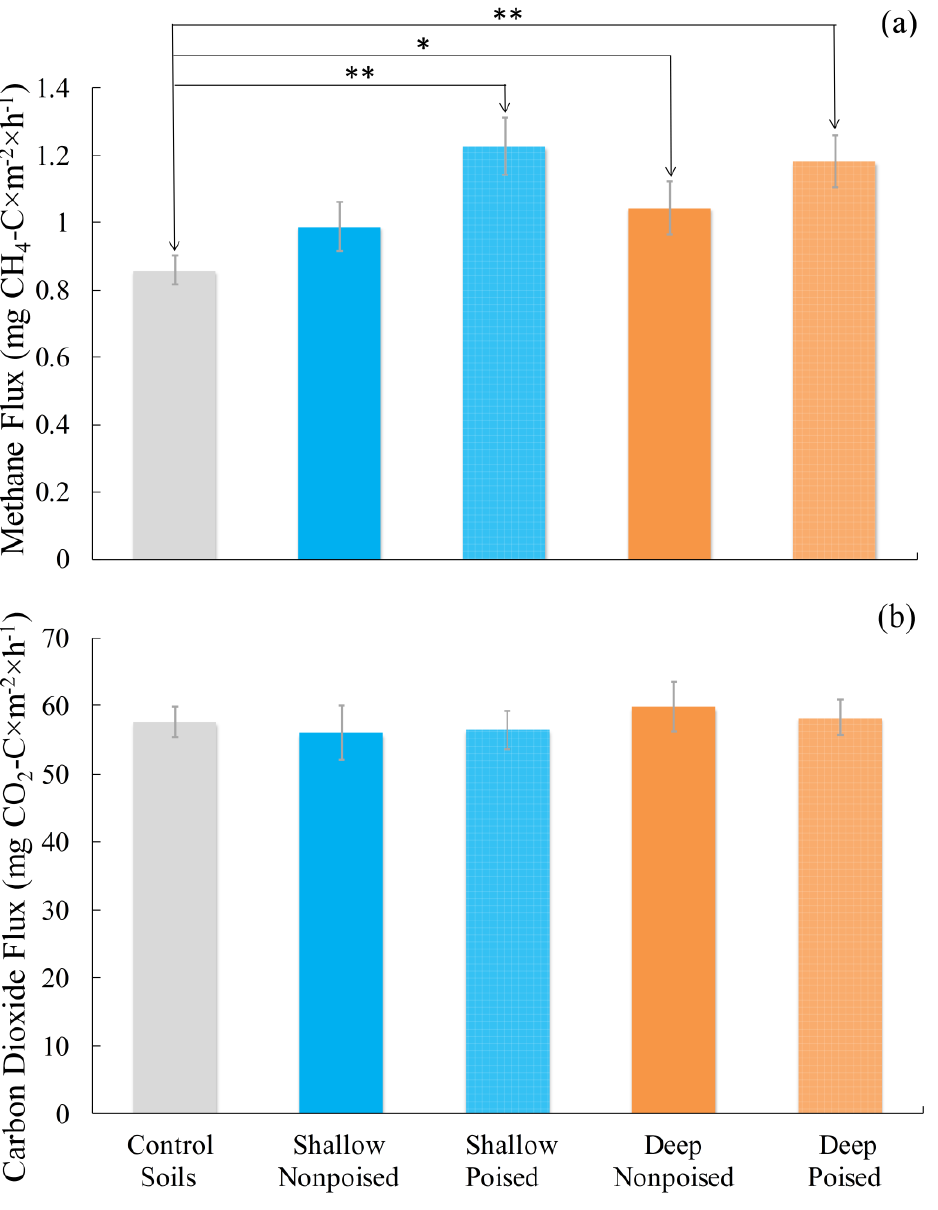
Figure 1. Average ( a ) methane and ( b ) carbon dioxide fluxes from the five different soil chamber types over a five-week experimental period. Chambers with nonpoised electrodes had higher methane fluxes ( a ) than the control chambers, but the largest differences from the control were in the chambers with poised electrodes. There were no significant differences in carbon dioxide emissions between different chamber types ( b ). Error bars indicate standard error and statistically significant differences at the p = 0.05 (*) and p = 0.0001 (**) are noted. We used two-sample t